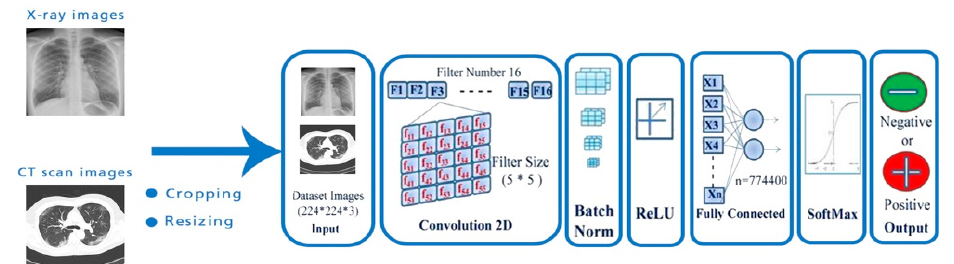
Figure 2. Architecture of a convolutional neural network (CNN) that helps to perform clinical diagnoses using X-ray and CT images.